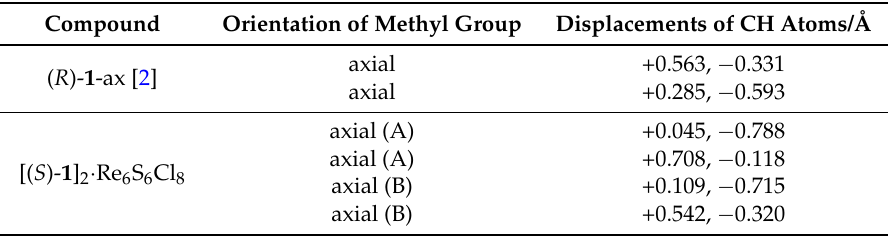
Table 1. Orientations of methyl groups and displacements of methine carbon atoms with respect to the mean plane formed by the other four atoms of the six-membered rings in [( S )- 1 ] 2 ¨ Re 6 S 6 Cl 8 and ( R )- 1 .